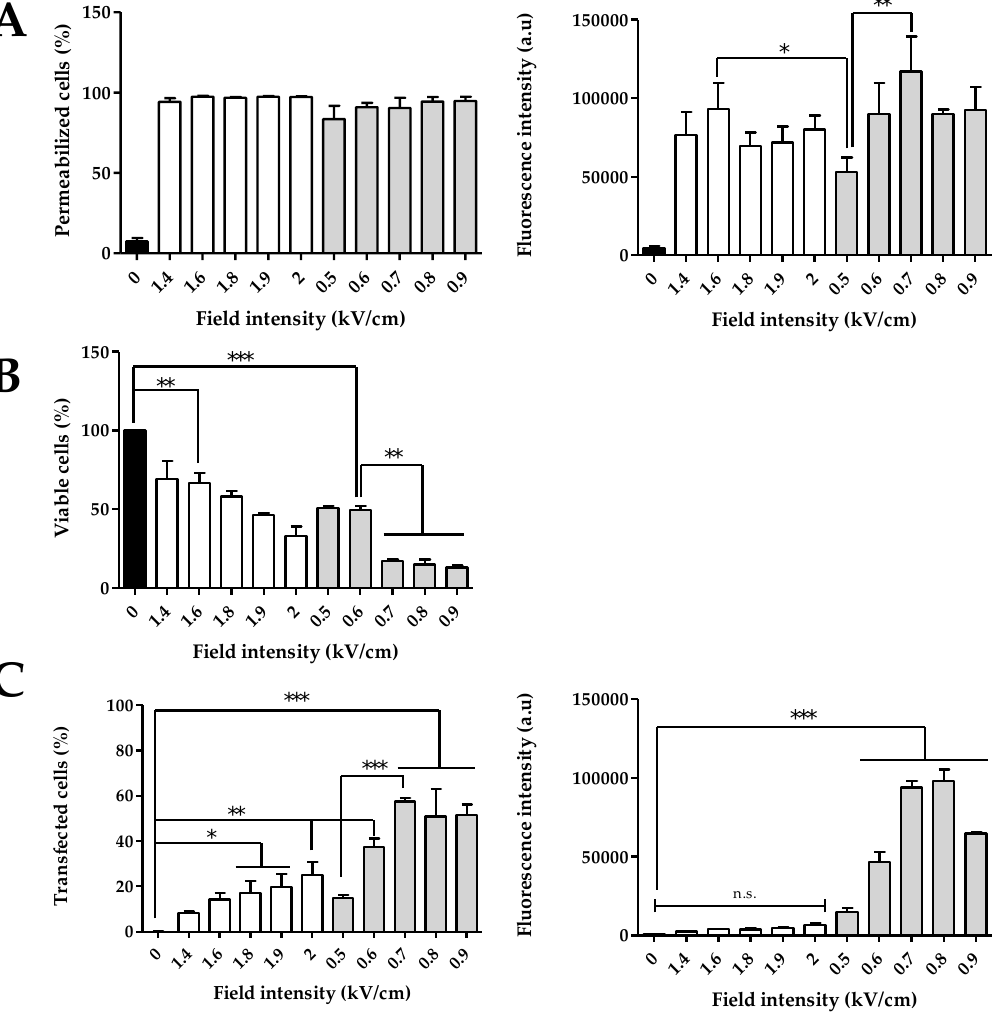
Figure 2. Effect of GET and ECT pulse parameters on HCT-116 cells as function of field intensity. ( A ) Percentages of permeabilization and associated fluorescence intensity, ( B ) cells viability, ( C ) percentages of transfected cells and associated fluorescence intensity. White histograms: cells treated with ECT pulse parameters (8 pulses of 100 µs at 1 Hz), Light gray histograms: cells treated with GET pulse parameters (10 pulses of 5 ms at 1 Hz). Cells were incubated with PI 50 µM for electropermeabilization ( A ) and plasmid encoding tdTomato 40 µg/mL for gene electrotransfer ( C ). N = 3 independent experiments. One-way ANOVA test was performed. *** p < 0.001, ** p < 0.01, * p < 0.05.